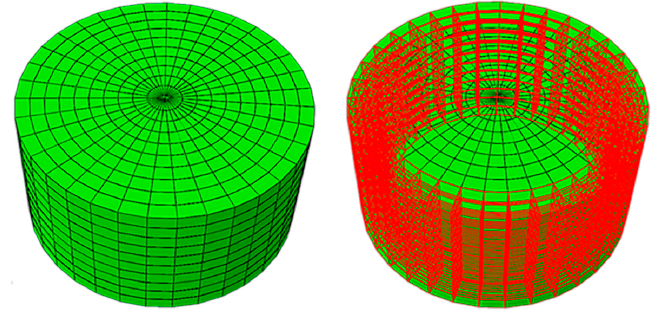
Figure 4. Cohesive finite element (CFE) model for the coarse-grained (CG) specimen.